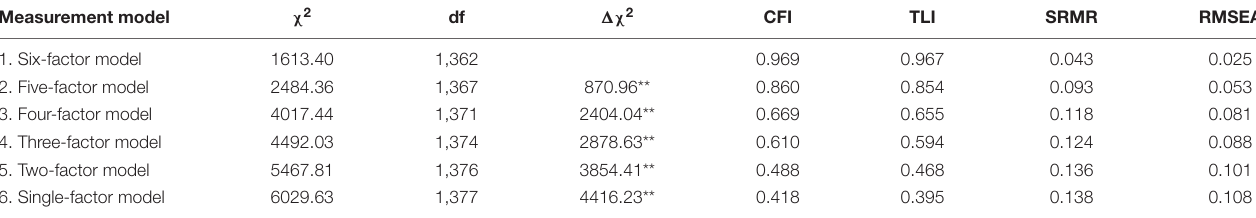
TABLE 1 | Results of confirmatory factor analysis.